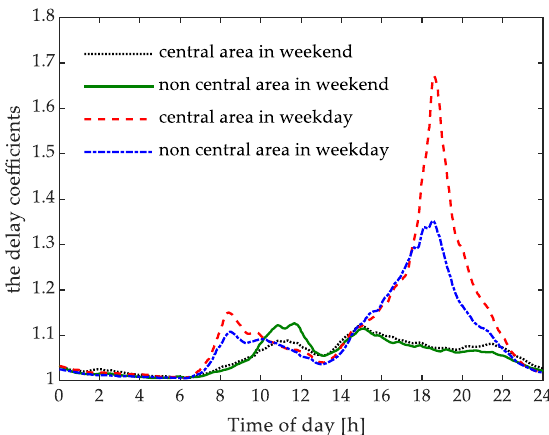
ffi cients under di ff erent tra ffi c index. Figure 9. Delay coefficients under different traffic index. Figure 9. Delay coe